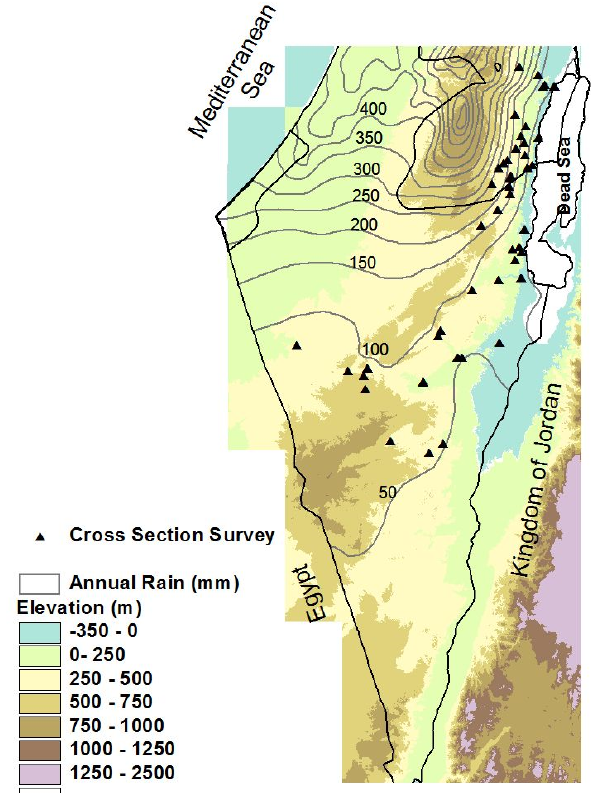
Fig. 1. A topographic map with the location of the surveyed cross sections. Annual climatic isohyets are also